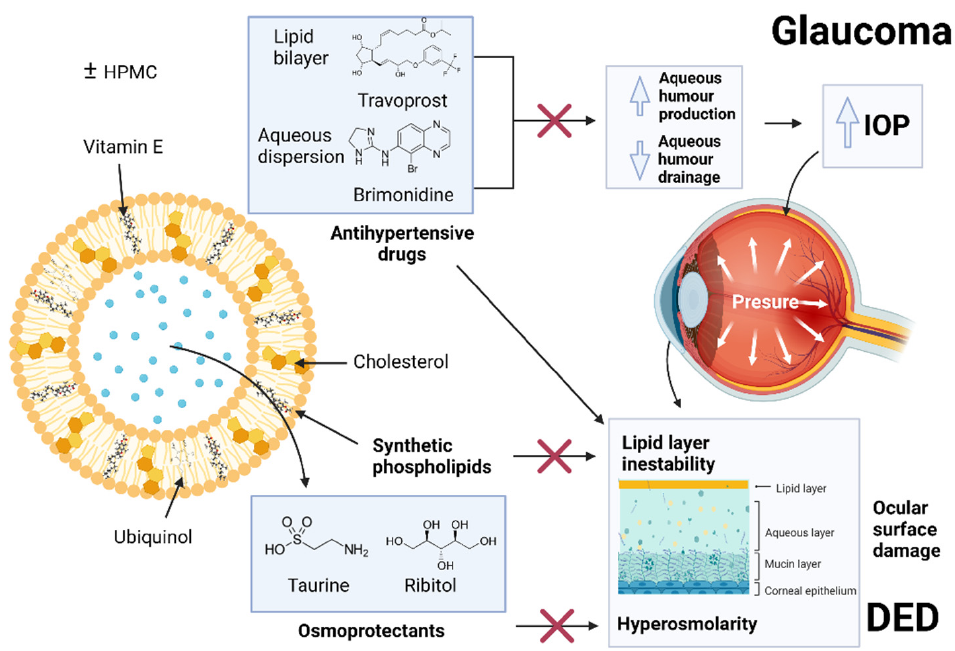
Figure 13. Liposome structure and mechanism for the treatment of glaucoma and prevention of dry eye.